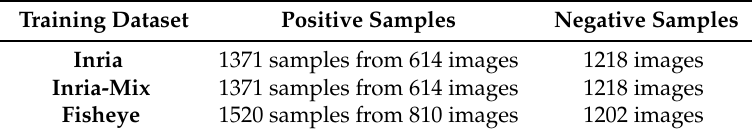
Table 2. Training datasets’ characteristics.